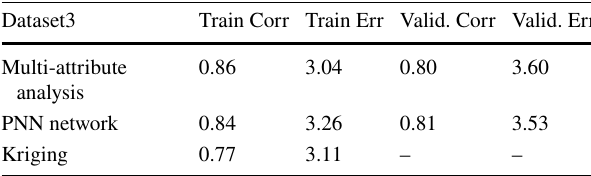
Table 15 The results of three different methods for third category data